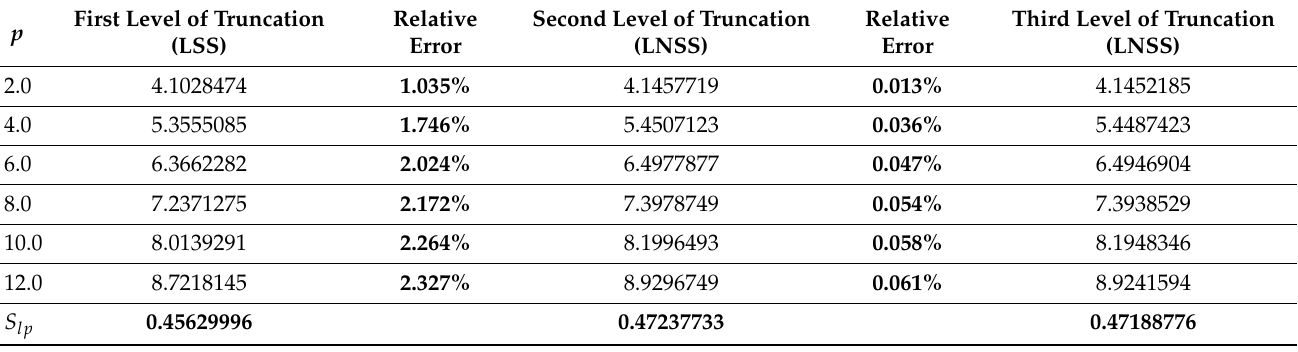
−√ (cid:18) (cid:19) √ p + 1 √ d 2 f ( χ = 0, ξ ) − Cf x Re x = for different values of velocity d χ 2 2